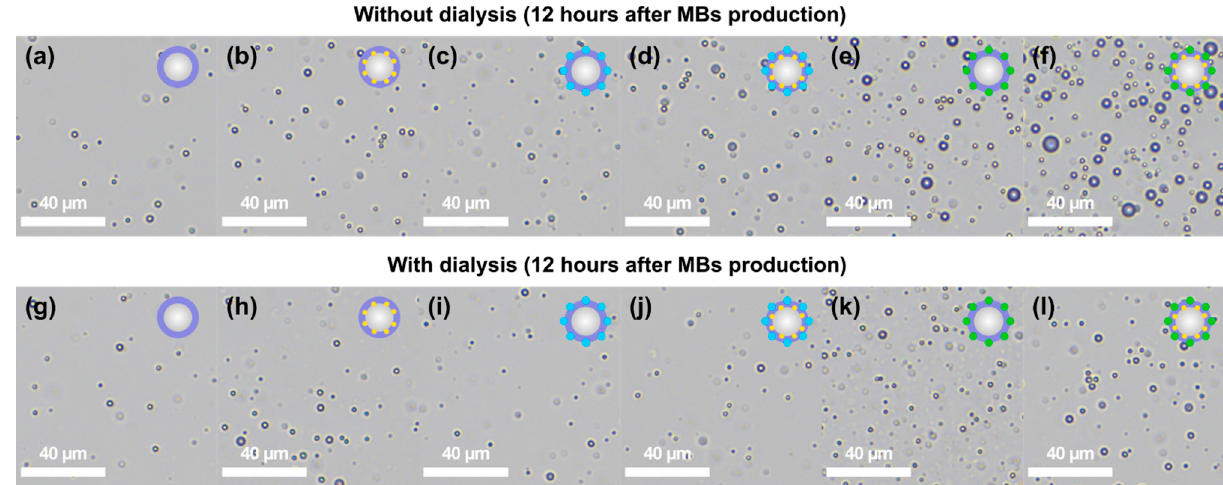
Figure 5. Optical microscopy (OM) images of air-filled bubbles 12 h after the preparation: ( a ) BSA MBs, ( b ) BSA-AuNPs MBs, ( c ) BSA-ZnPc MBs, ( d ) BSA-ZnPc-AuNPs MBs, ( e ) BSA-ICG MBs, ( f ) BSA-ICG-AuNPs MBs without dialysis, and ( g ) BSA MBs, ( h ) BSA-AuNPs MBs, ( i ) BSA-ZnPc MBs, ( j ) BSA-ZnPc-AuNPs MBs, ( k ) BSA-ICG MBs, ( l ) BSA-ICG-AuNPs MBs with dialysis.